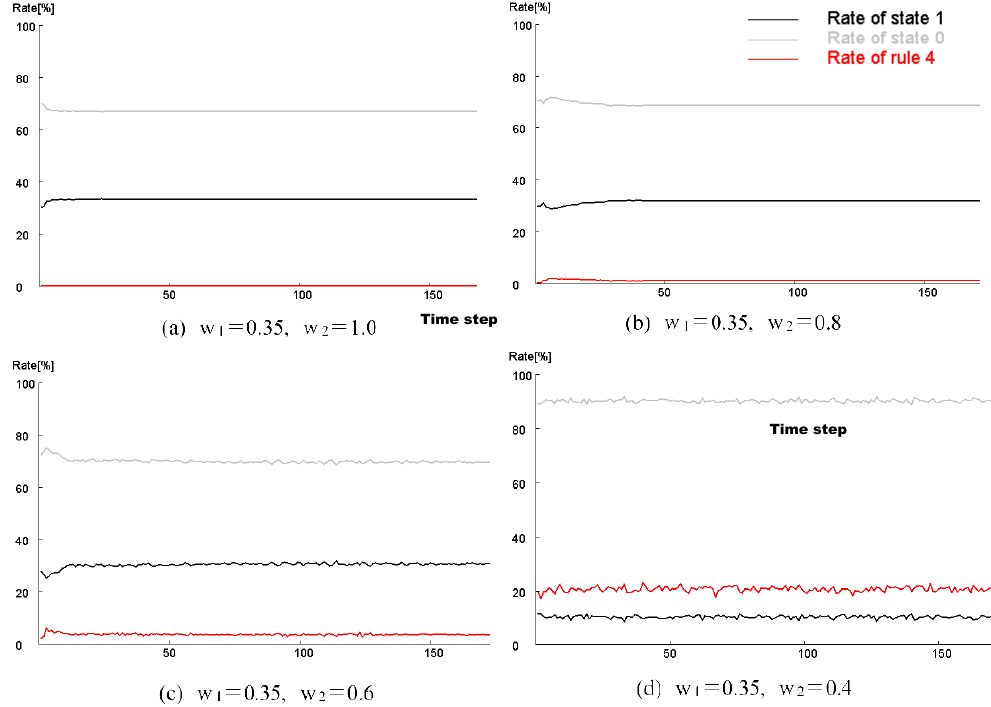
Figure 10. Transition ratio of states 1 and 2, and the ratio of the applied cells of Rule 4 at each time step. This result was calculated when w 2 was changed in s = 5, t = 9, and w 1 = 0.35. When w 2 was 1, Rule 4 was not applied, and it was equivalent to the Young model. As w 2 was lowered, the application ratio of Rule 4 increased. In comparison with Figure 8, white regions were generated in the black spots, and instability increased and began pulsating. This phenomenon is attributed to Rule 4.